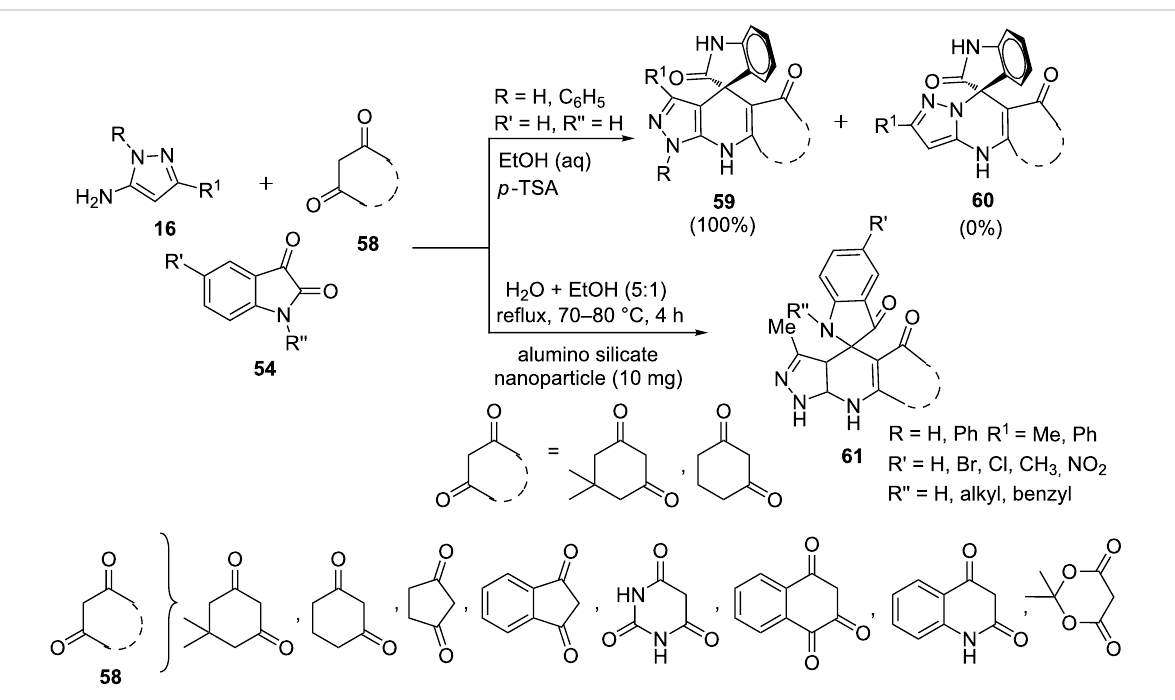
Scheme 13: Nanoparticle-catalyzed synthesis of pyrazolo[3,4- b